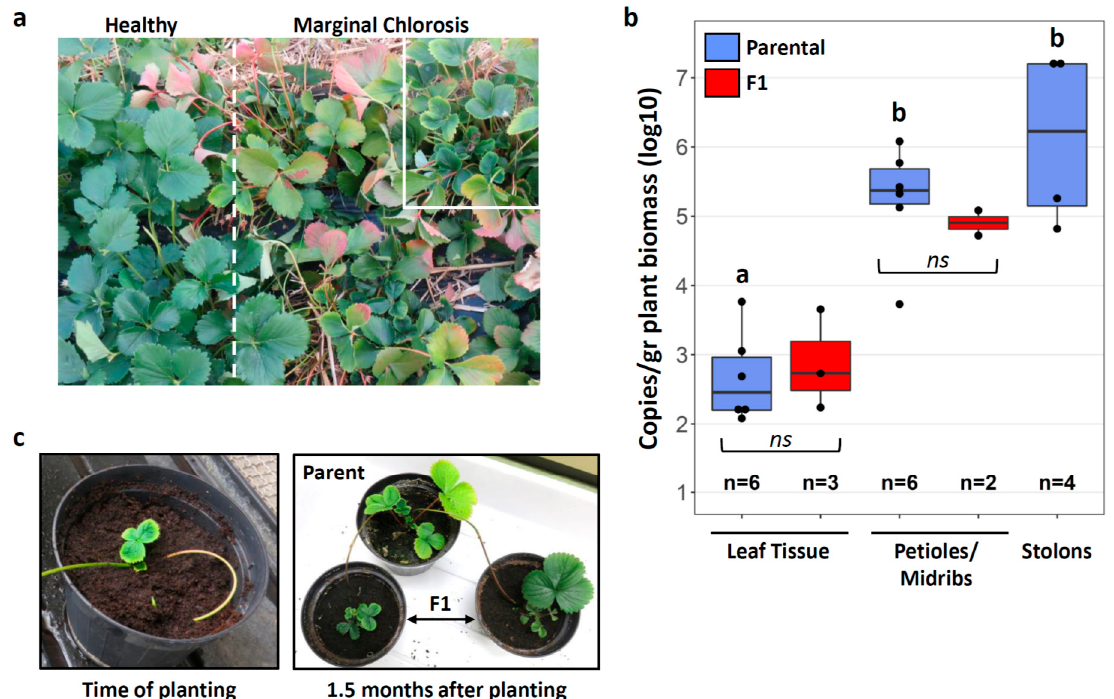
Figure 1. Stolon transmission of Phlomobacter. ( a ) Strawberry production field with both healthy and diseased plants, separated by the dashed line. The white box highlights plants showing the characteristic symptoms of Marginal Chlorosis diseases, i.e., small, cup-shaped leaves with yellow chlorosis along the leaf margins. ( b ) Quantification of Phlomobacter titers in different tissues of naturally infected parental plants (blue) and stolon-derived F1 daughter plants (red). Sample sizes are provided below each box plot. Different letters above the box plots indicate significant differences based on ANOVA followed by Tukey’s post-hoc test. ( c ) Leaves of stolon-derived daughter plants immediately developed disease symptoms.